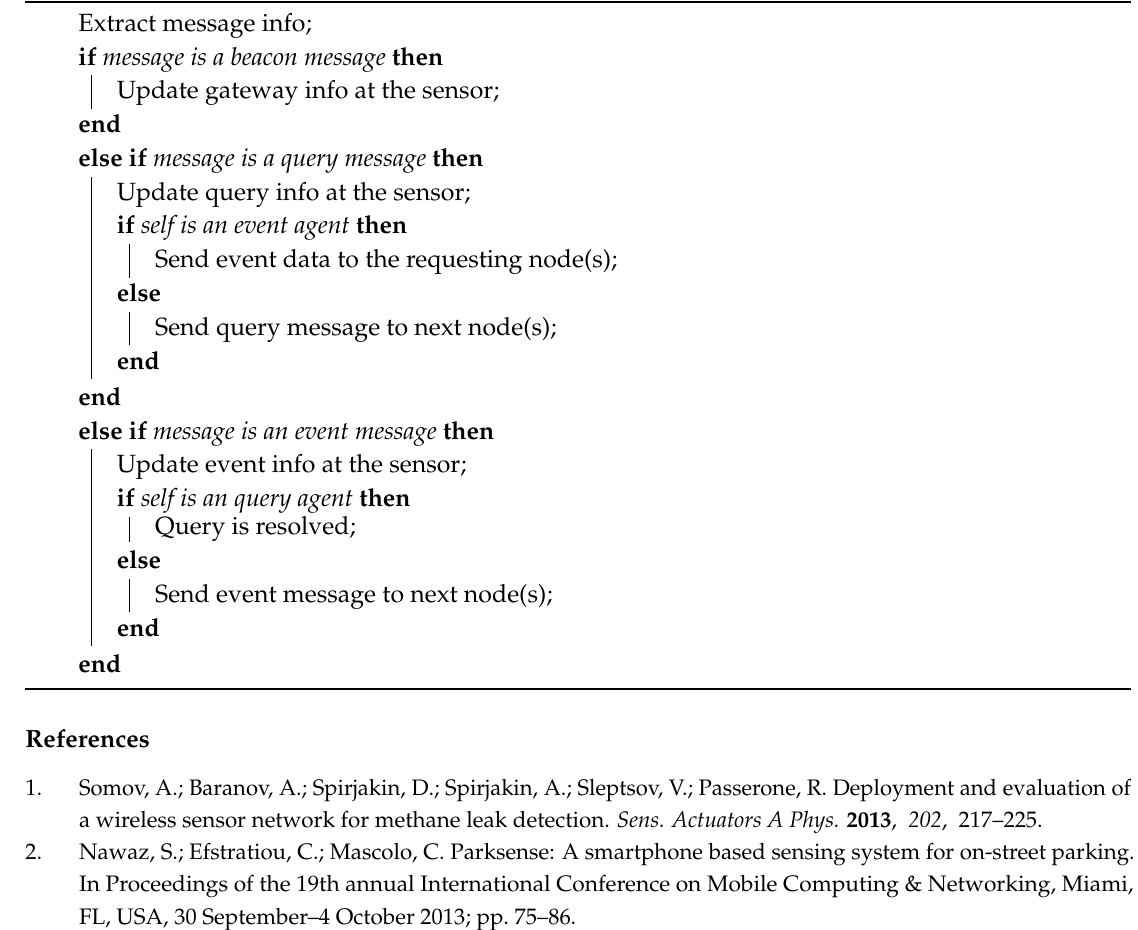
Algorithm C1: Processing New Message Algorithm at a Sensor